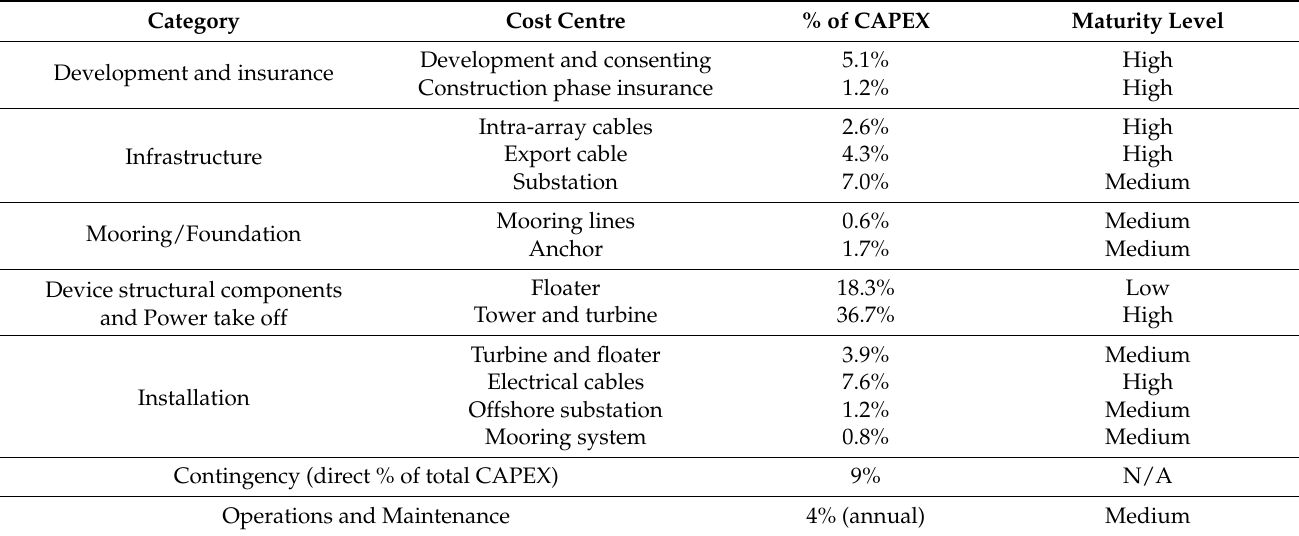
Table 4. Cost centre breakdown and corresponding maturity levels assumed for floating offshore wind; cost data based on [23].